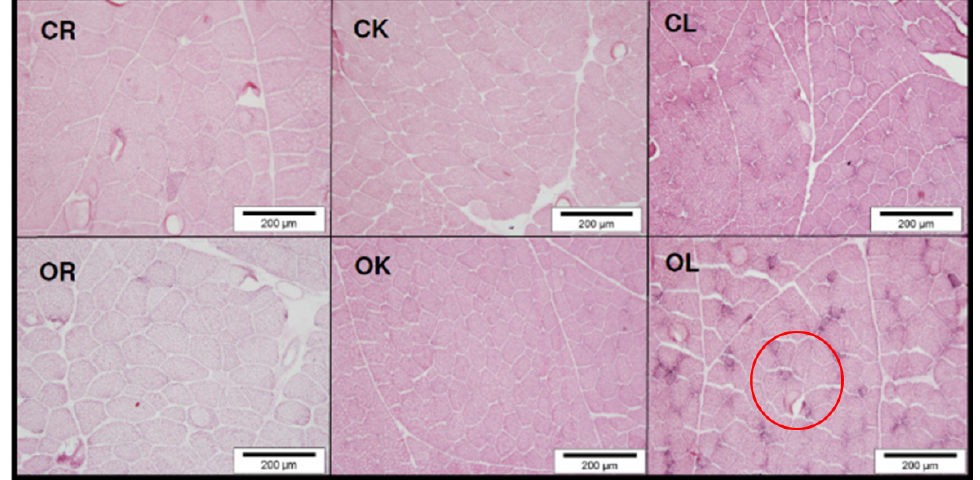
Figure 5. Comparison of Pectoralis major muscle cross taken from conventional Ross 308 (CR); conventional Kabir (CK) or conventional Leghorn (CL); and organic Ross 308 (OR), organic Kabir, (OK) or organic Leghorn (OL) chickens; in the circle: α -red fibers (modified by [20]).